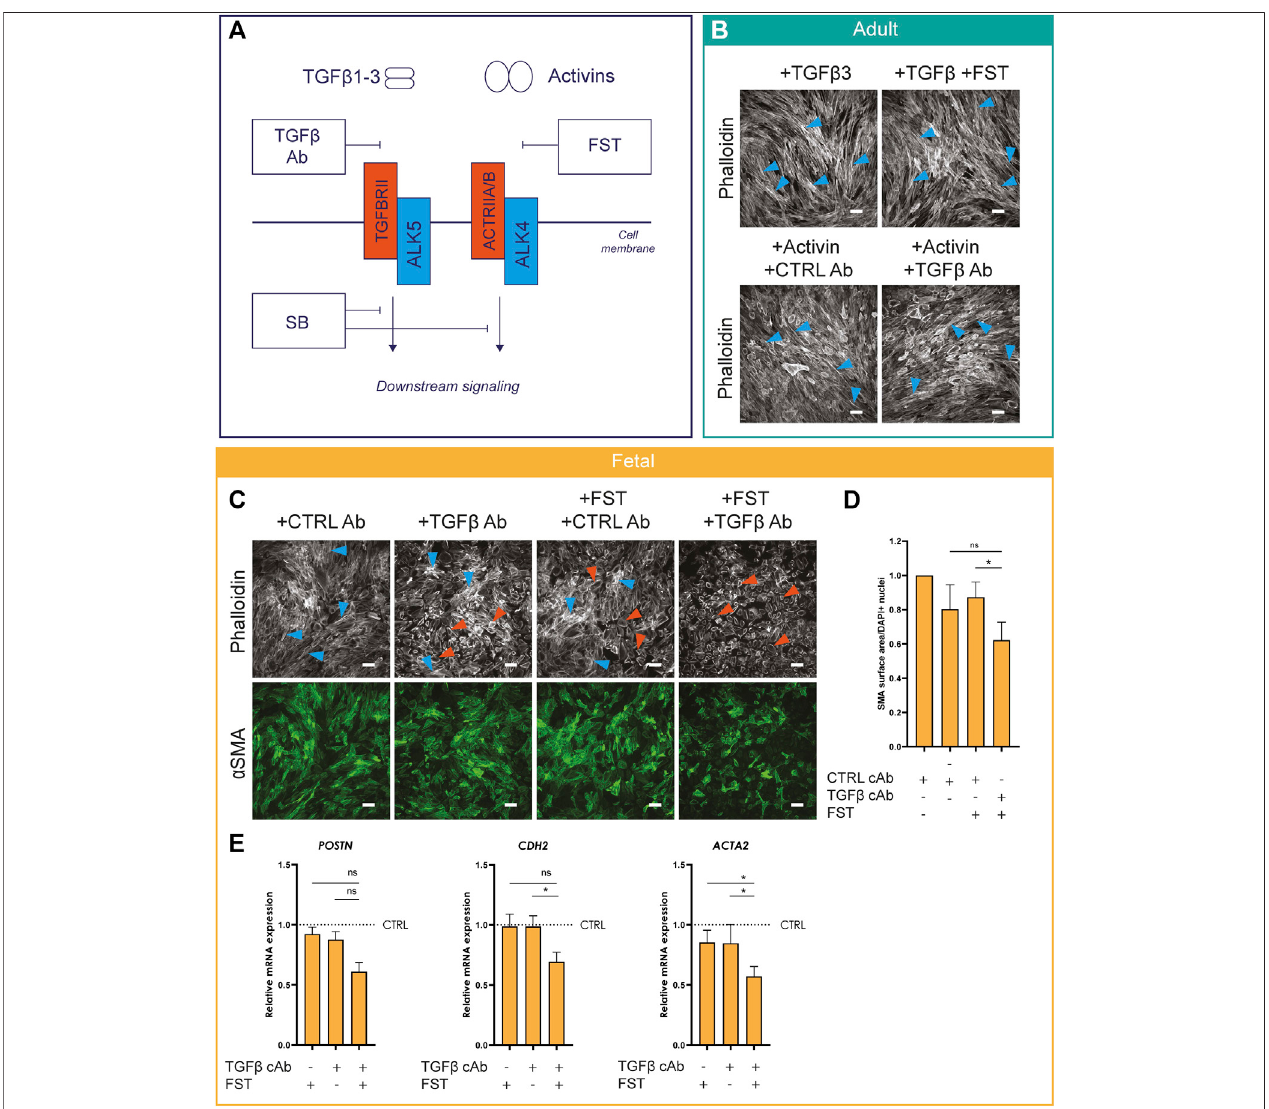
FIGURE 4 | Activin A-induced epiMT is independent of TGF β signaling (A) Schematic overview of TGF β and Activin signaling and their concomitant inhibitors. (B) Phalloidinstainingofadult EPDCscultured for5 days in thepresence ofTGF β 3,TGF β 3+FST, ActA+ CTRL capture Ab (cAb), orActivin A+TGF β cAb( n (cid:1) 3). Scale bar: 100 µm. (C) Phalloidin and α SMA staining ( n (cid:1) 5) of fetal EPDCs cultured for 5 days in the presence of Activin A or TGF β inhibitors. Scale bar: 100 µm. Orange arrows indicate examples of epithelial cobblestone-shaped cells, blue arrows of mesenchymal spindle-shaped cells. (D) Quanti fi cation of α SMA area ( n (cid:1) 4), * (cid:1) p < 0.05 (mixed-effects analysis, Sidak ’ s multiple comparisons test). Data are displayed as mean +SEM. (E) mRNA expression levels of POSTN , ACTA2 , CDH2 ( n (cid:1) 4) of fetal EPDCs cultured for 5 days. * (cid:1) p < 0.05, ns (cid:1) not signi fi cant (mixed-effects analysis, Sidak ’ s multiple comparisons test). Data are displayed as mean + SEM.